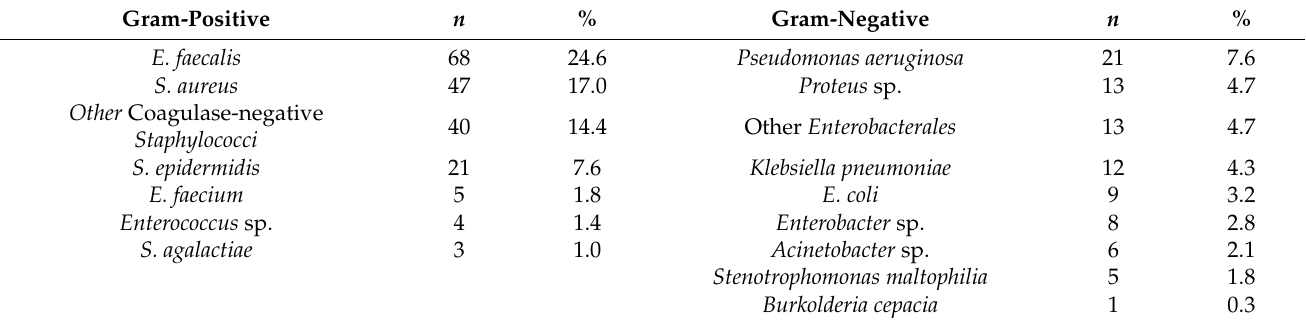
Table 1. Isolated pathogens in patients admitted with DFI ( n = 276).